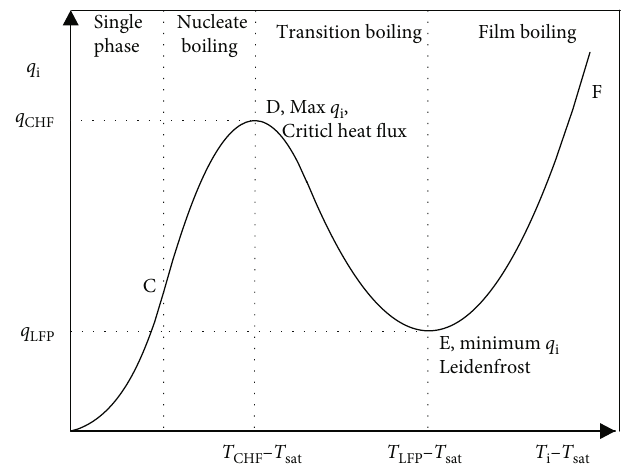
Figure 1: Typical boiling curve and fl ow patterns for chill-down